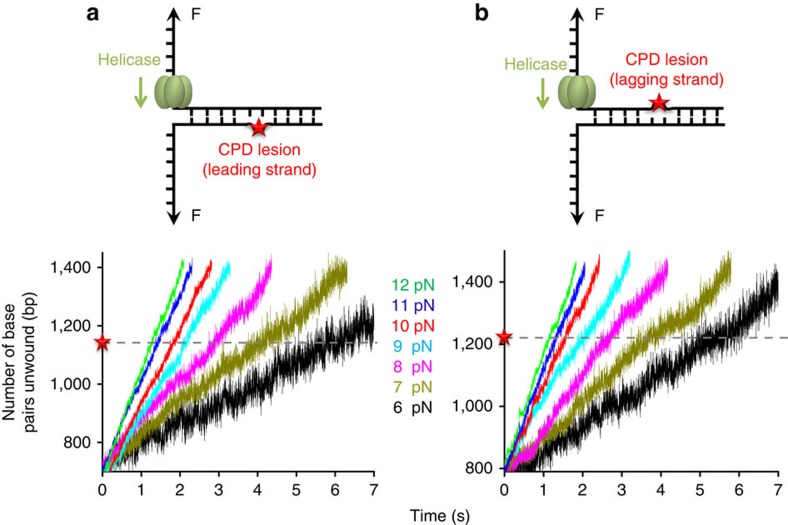
Helicase unwinding through a cis-syn CPD lesion.The two single-stranded ends of a dsDNA were held at a constant unzipping force of 6–12 pN as T7 helicase unwound the dsDNA. A CPD lesion (red star) was located in either the leading- (a) or lagging- (b) strand DNA. Representative traces show the number of unwound base pairs versus time in the presence of 2-mM Thymidine triphosphate (dTTP). For clarity, traces have been shifted along the time axis. The dotted lines indicate the lesion position.